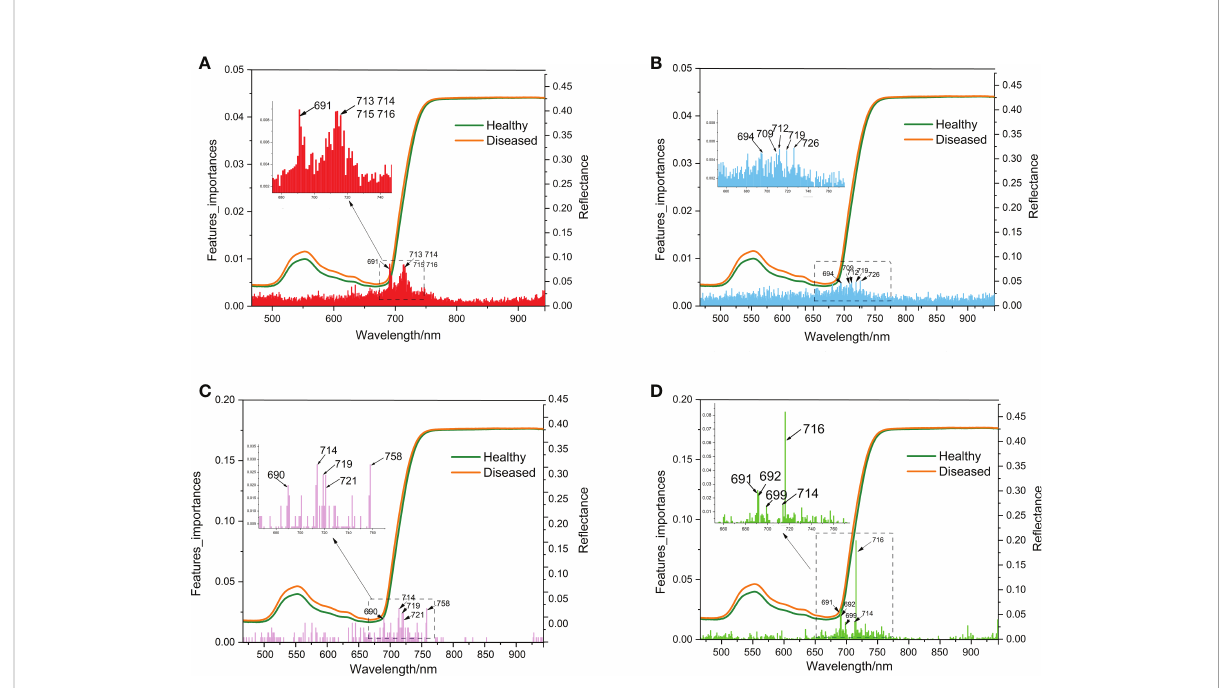
FIGURE 7 Schematic diagram of wavelength importance analysis of the 4 models ( A : RF, B : ET, C : ADA, D : GBDT) same as Figure 6.